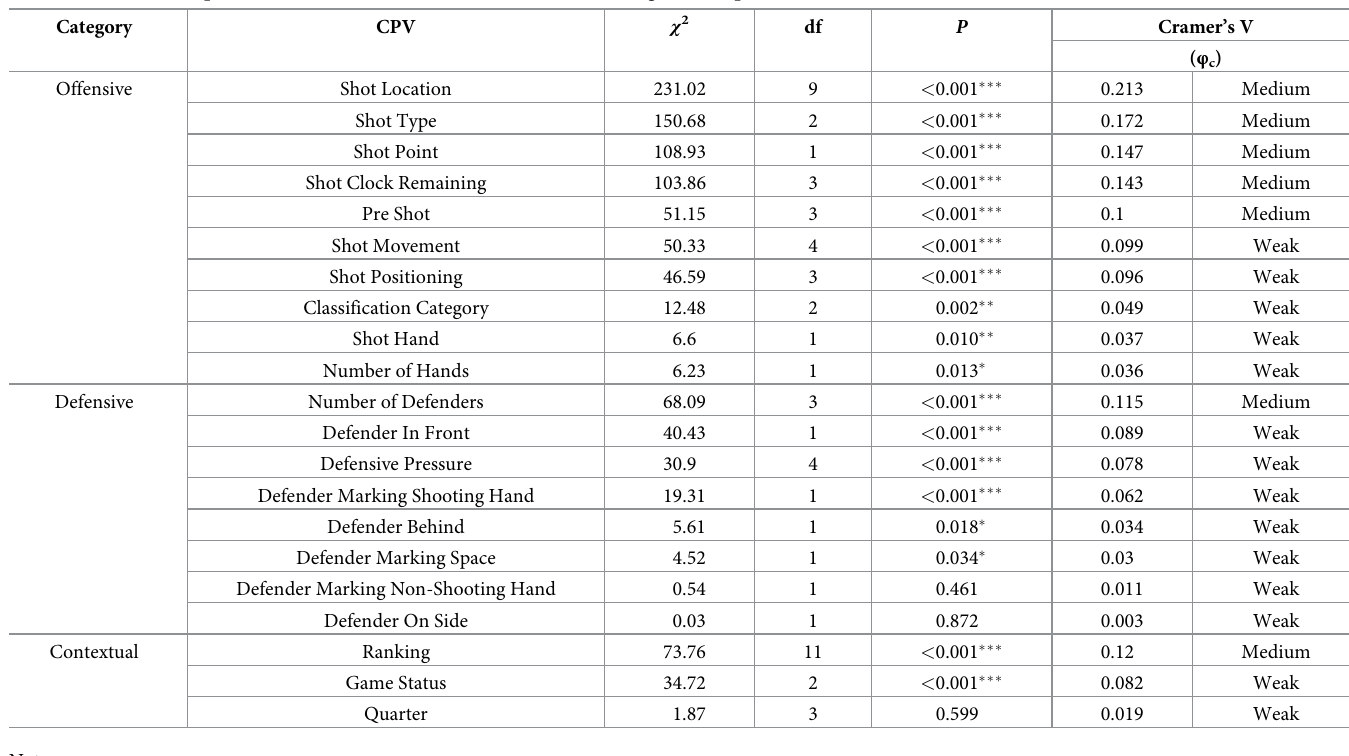
Clock Remaining, Ranking, Number of Defenders, Classification Category, Shot Movement, Pre Shot and Defensive Pressure. The predictive accuracy of the model for shooting success found no evidence of poor fit when the Hosmer-Lemeshow Goodness of Fit Test was used ( χ 2(8) = 9.967, p = .267). Table 4 summarises the results of the final model, with Chi-squared likelihood ratio tests showing that these CPVs all uniquely contributed to the model: Shot Location ( χ 2 (9) = 75.38, p < .001), Shot Clock Remaining ( χ 2 (3) = 31.64, p < 001), Ranking ( χ 2 (11) = 47.33, p < .001), Number of Defenders ( χ 2 (3) = 19.45, p < .001), Classification Category ( χ 2 (2) = 35.63, p < .001), Shot Movement ( χ 2 (4) = 17.85, p < .001), Pre Shot ( χ 2 (2) = 12.81, p = .005) and Defensive Pressure ( χ 2 (3) = 8.30, p = .081), that whilst not presenting a statistically significant contribution, improved the model fit when it was retained. The regression equation derived from the model was then used for predicting the accuracy of the binary logistic regression model against the 30% out of sample testing data (1,531 shots). An area under the ROC curve value of 0.685 was established for the model when predicting field-goal attempt outcome within the out of sample testing data, identifying that the model was able to accurately classify field-goal outcome 68.5% of the time, which represents a good level of discriminant capacity ( > 0.65%) [28,30]. Table 4 also shows the individual parameter estimates for each action variable, within a CPV, and their associated standard errors (SE), Z-statistics, p-values Odds Ratios (OR) and